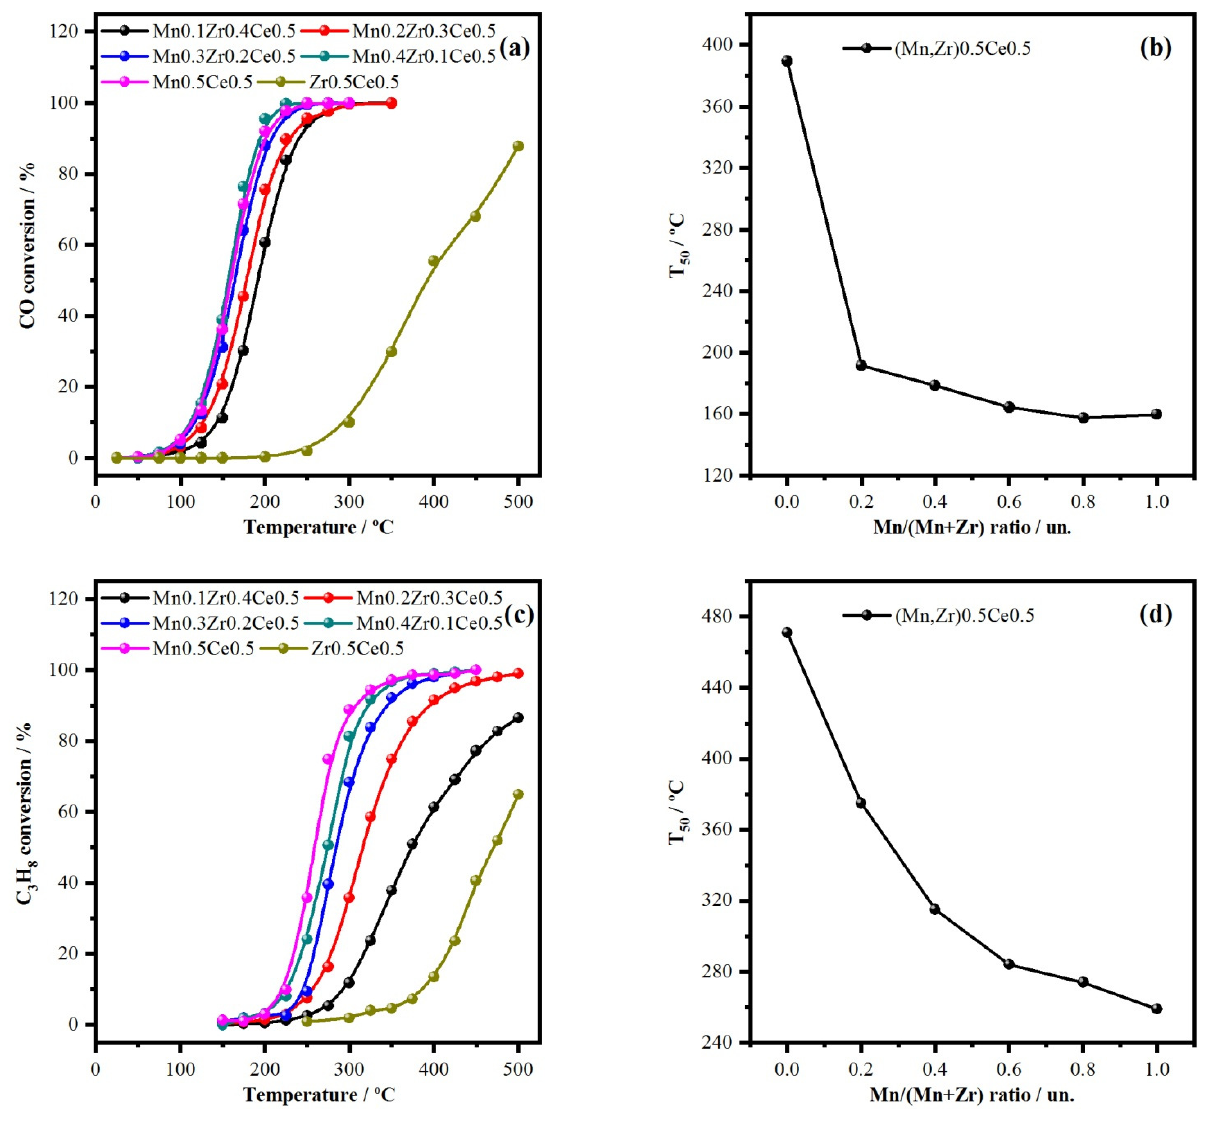
Figure 1. Reaction temperature dependence of ( a ) CO and ( c ) C 3 H 8 conversion; the molar ratio Mn/(Mn + Zr) dependence of T 50 for ( b ) CO and ( d ) C 3 H 8 conversion in oxidation reaction over (Mn,Zr)0.5Ce0.5 catalysts.